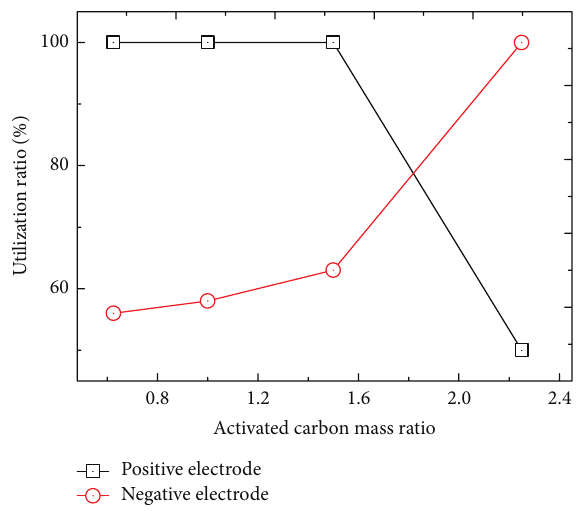
Figure 2: Relation between utilization and mass ratio of AC.